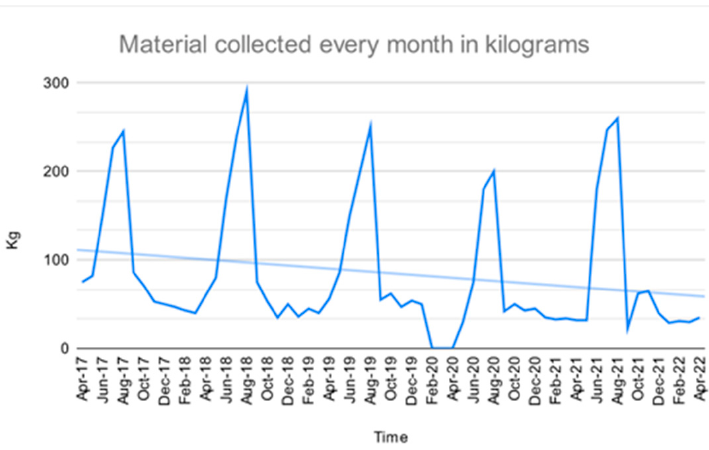
Figure 1. The amount of collected material from April 2017 to April 2022 (in kg).